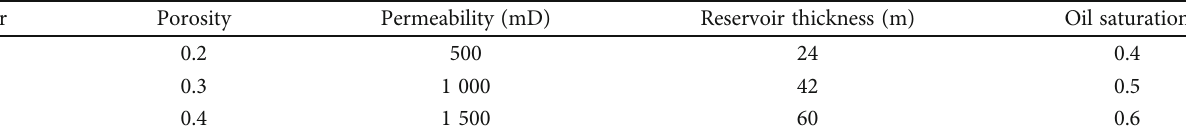
Table 1: Value level of reservoir geological factors.